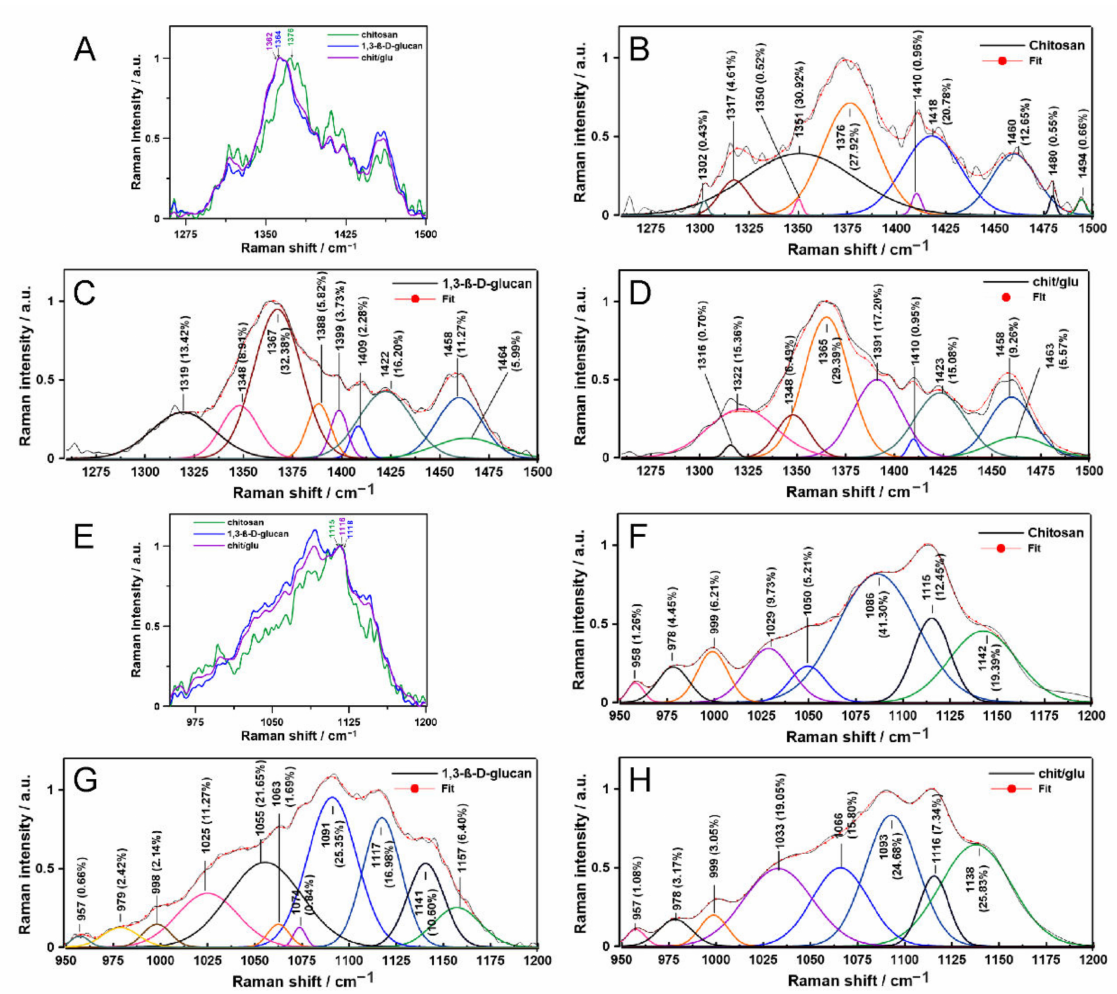
Figure 3. The normalized Raman intensity ( A , E ) spectra in the selected ranges and band deconvolu- tion with the application of mixed Lorentzian/Gaussian curve fitting (( B – D ): 1260–1500 cm − 1 , and ( F – H ): 950–1200 cm − 1 ). Each subband has marked a maximum value and a percentage share of the whole band surface